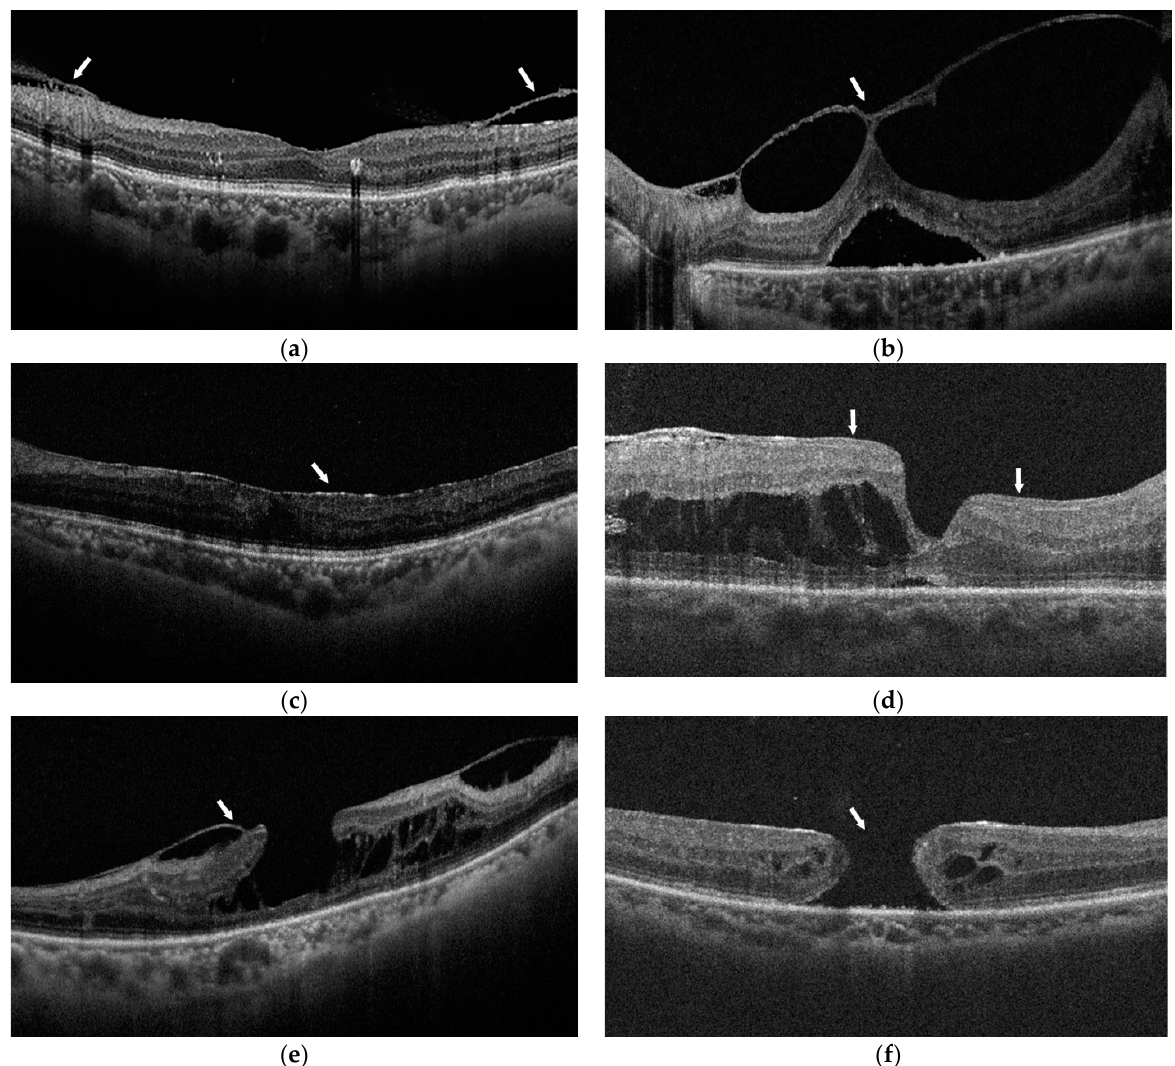
Figure 1. Classifications of vitreomacular interface disorders (VMID) (white arrows) on optical co- herence tomography (OCT): ( a ) vitreomacular adherence (VMA); ( b ) vitreomacular traction (VMT);